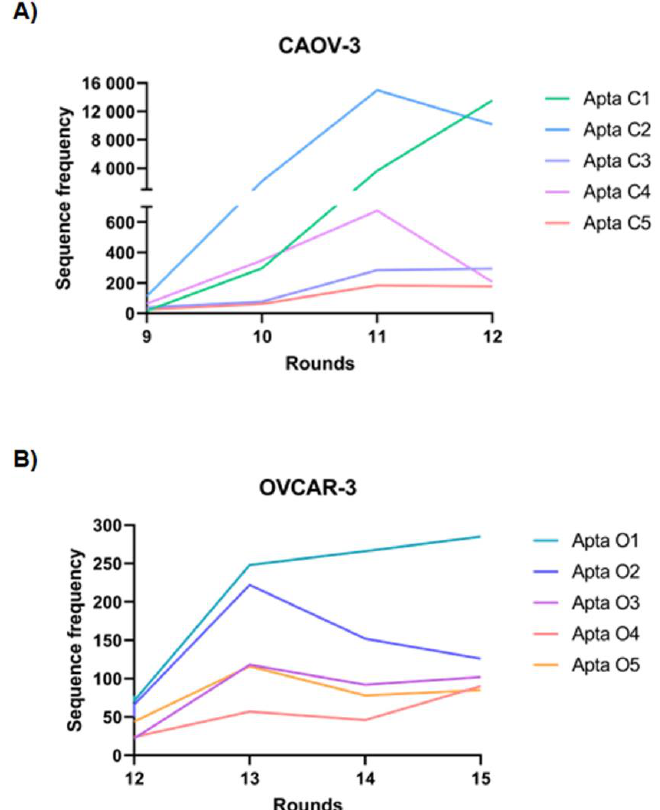
Figure 1. Graph demonstrating the enrichment of the five most abundant individual aptamers in the last rounds of Cell-Selex. ( A ) Aptamers frequency selected for Caov-3 cell line: AptaC1, AptaC2, AptaC3, AptaC4, and AptaC5 over the R9, R10, R11, and R12 rounds. ( B ) Aptamers frequency se- lected for OvCar-3 cell line: AptaO1, AptaO2, AptaO3, AptaO4, and AptaO5 over the R12, R13, R14, and R15 rounds.